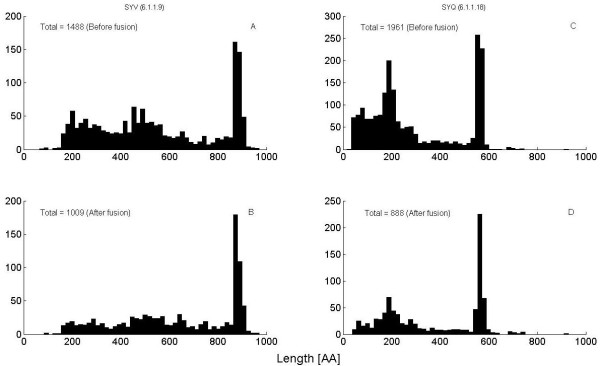
Length distributions of putative proteins. Histogram of the length of sections of enzymes. Lengths derived from the 1488 PPs that contain a hit of SP = ISRQLWWGH (EC = 6.1.1.9) before (A) and after (B) obtaining a solution of the minimal number of mutually inconsistent sequences by the taxa-counting algorithm. Lengths derived from the 1961 PPs that contain a hit of SP = TRFPPEPNGYLH (EC = 6.1.1.18), before (C) and after (D) the algorithm.